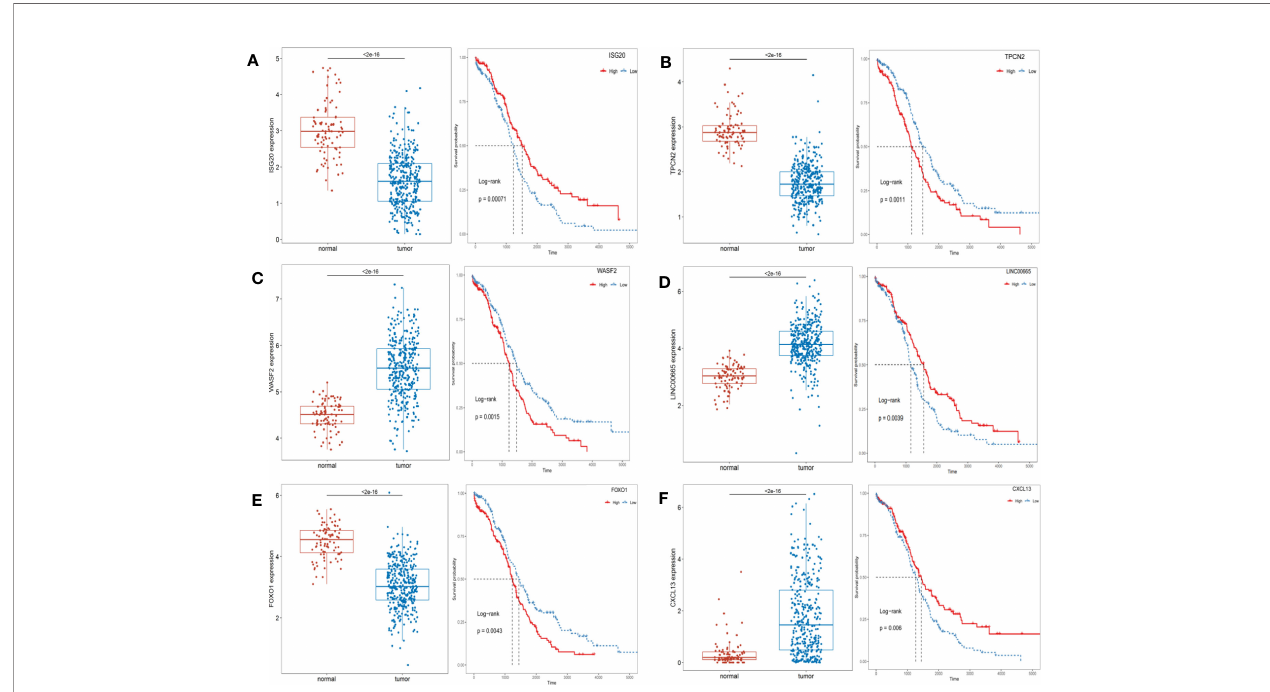
FIGURE 3 | The expression levels of prognosis-related top 6 ARGs between the normal and OC patients and Kaplan-Meier curves in the high- and low-risk groups. (A) ISG20; (B) TPCN2; (C) WASF2; (D) LIINC00665; (E) FOXO1; (F) CXCL13.